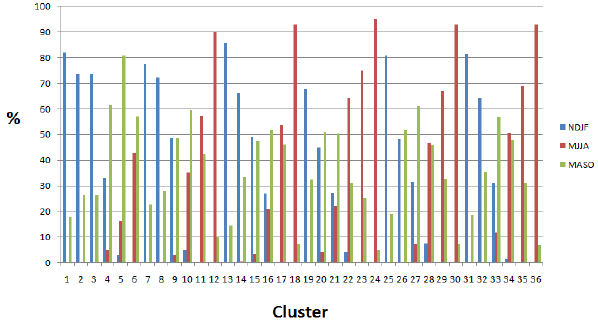
Fig. 2. Seasonal appearance (percentage) of the 36 clus- ters (NDJF=November, December, January and February; MJJA=May, June, July and August; MASO=March, April, September, October).